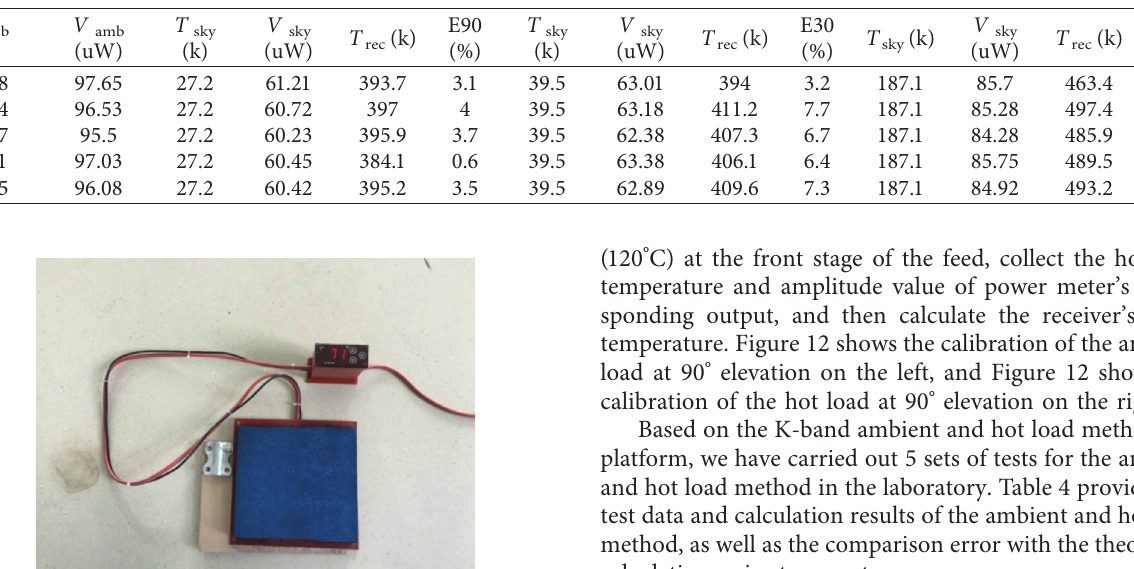
Figure 10: K-band chopper calibration platform and ambient Table 3: Test data and comparison results at 90, 30, and 5 degrees elevation.